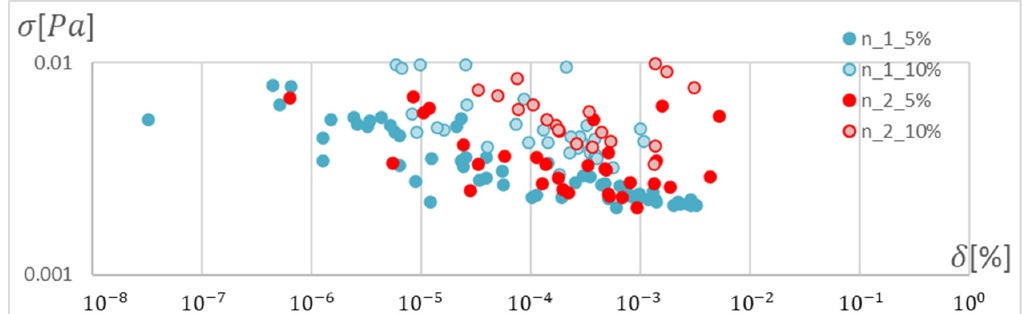
Figure 15. Pareto fronts for the two best-matched networks trained using the SCG algorithm.